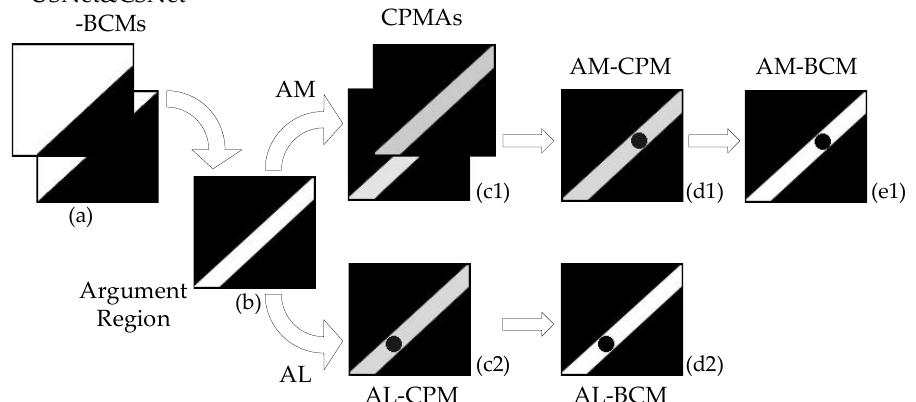
Figure 4. Process of re-estimating the argument region. ( a ): USNet&CSNet-BCMs; ( b ): Argument Region; ( c1 ): CPMAs; ( c2 ): AL-CPM; ( d1 ): AM-CPM; ( d2 ): AL-BCM; ( e1 ):